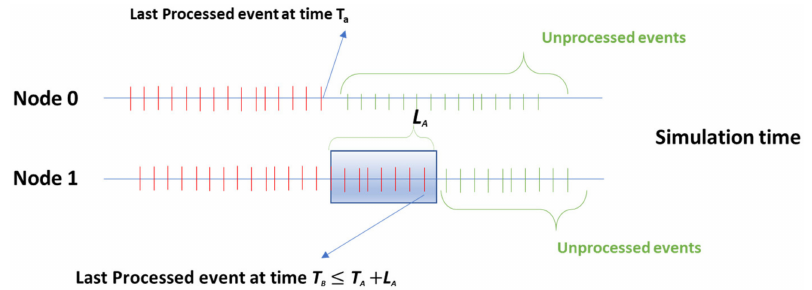
Figure 1. Fixed time buckets allow events to be scheduled and processed asynchronously using the concept of a global